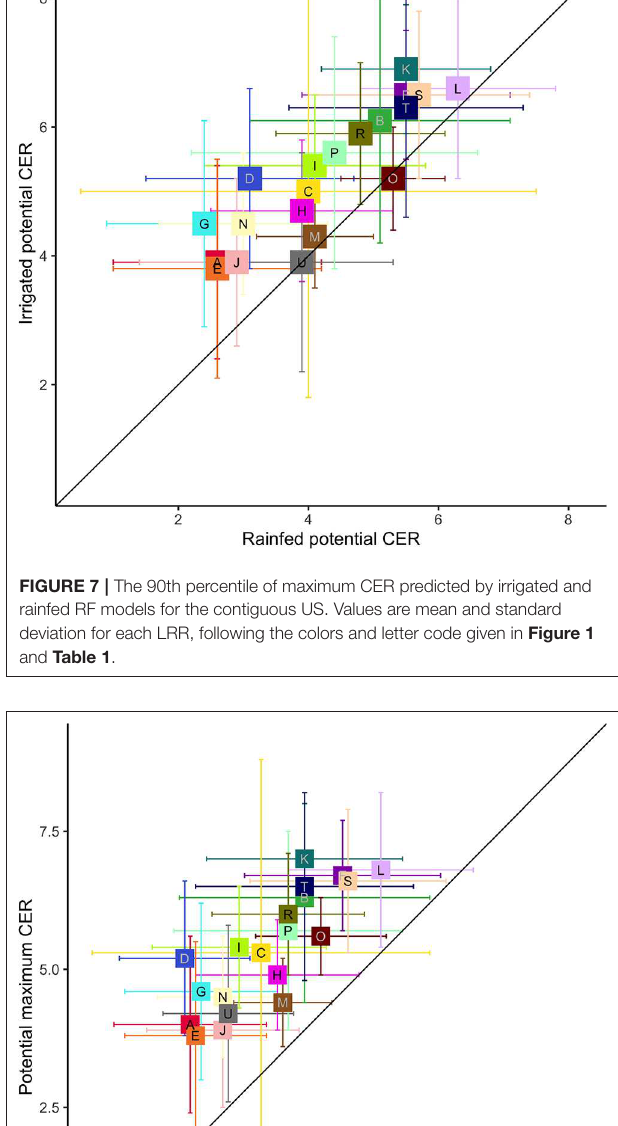
not increase, because its agricultural systems are already designed for irrigation. Florida CER also did not increase with irrigation; this region has high annual precipitation, but uses irrigation to compensate for precipitation variability (Zhang et al.,